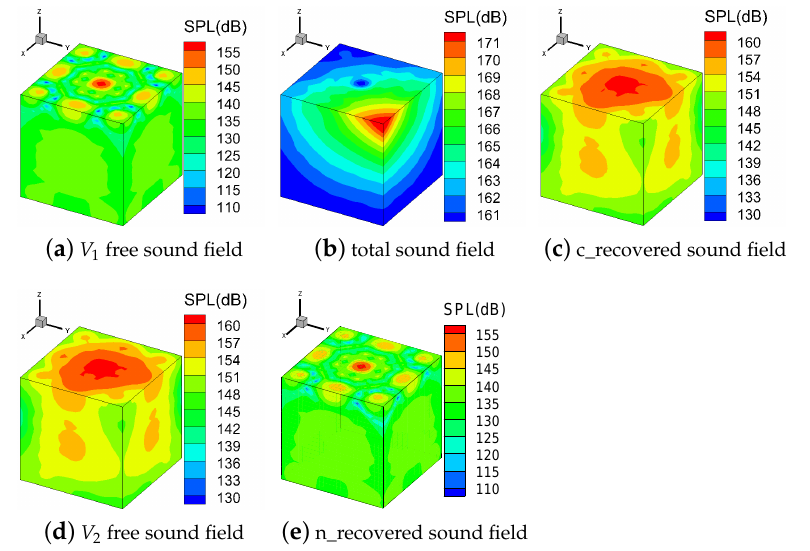
Figure 8. Contour map of sound pressure level (SPL) on the measurement surface at 700 Hz (ka = 2.9). Figure 9 shows the mean quadratic errors of the conventional recovered sound field, the new recovered sound field, and the total sound field to the V 1 free sound field and the V 2 free sound field. The mean quadratic errors of the total sound field to the V 1 free sound field and the V 2 free sound field are both over 100%. Influenced by the strong fluid–structure interaction, the conventional recovered sound field to the V 1 free sound field is also over 100%. However, the mean quadratic errors of the conventional recovered sound field to the V 2 free sound field are mostly less than 10%. Additionally, the mean quadratic errors of the new recovered sound field to the V 1 free sound field are mostly less than